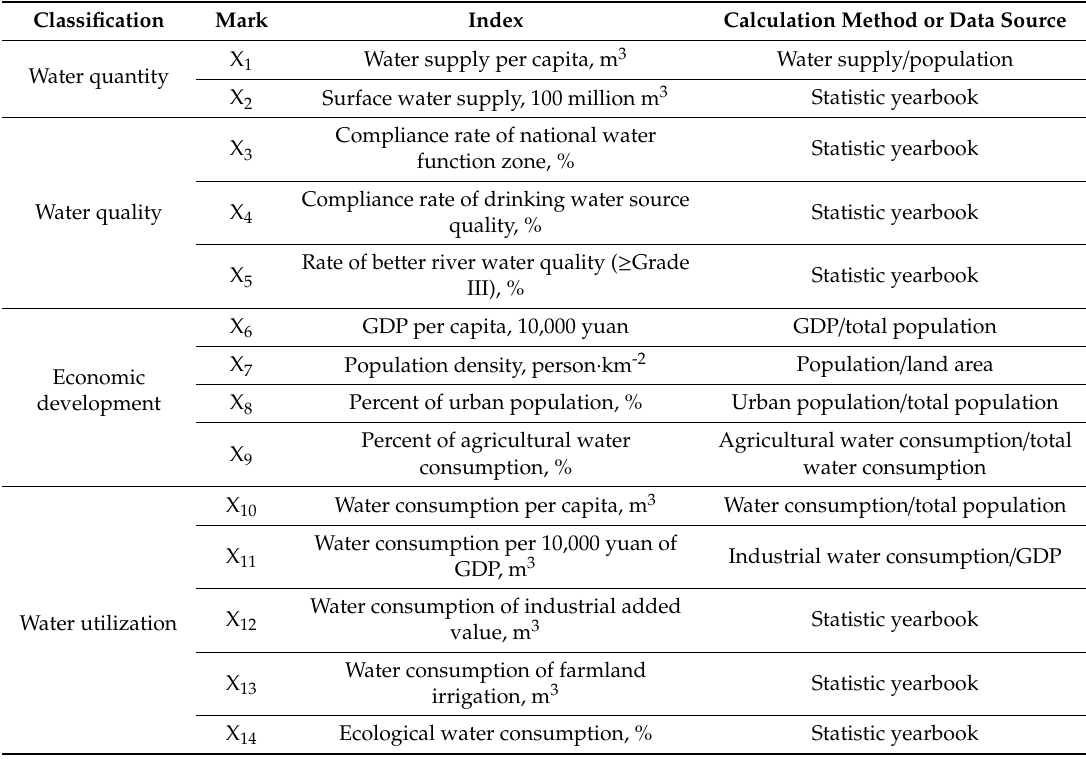
Table 2. Candidate indices for EWS-RWRCC in Anhui